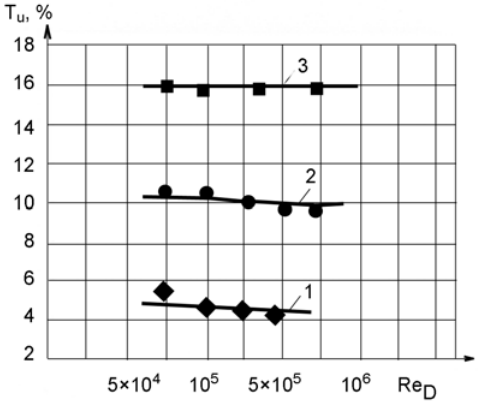
Fig 11. Dependence of turbulence degree of stream Tu on Reynolds' number Re D for sedimentation from ceramic high porosity material with different size of equivalent diameter of pours: 1 – d e = 0,4 mm; 2 – d e = 0,9 mm; 3